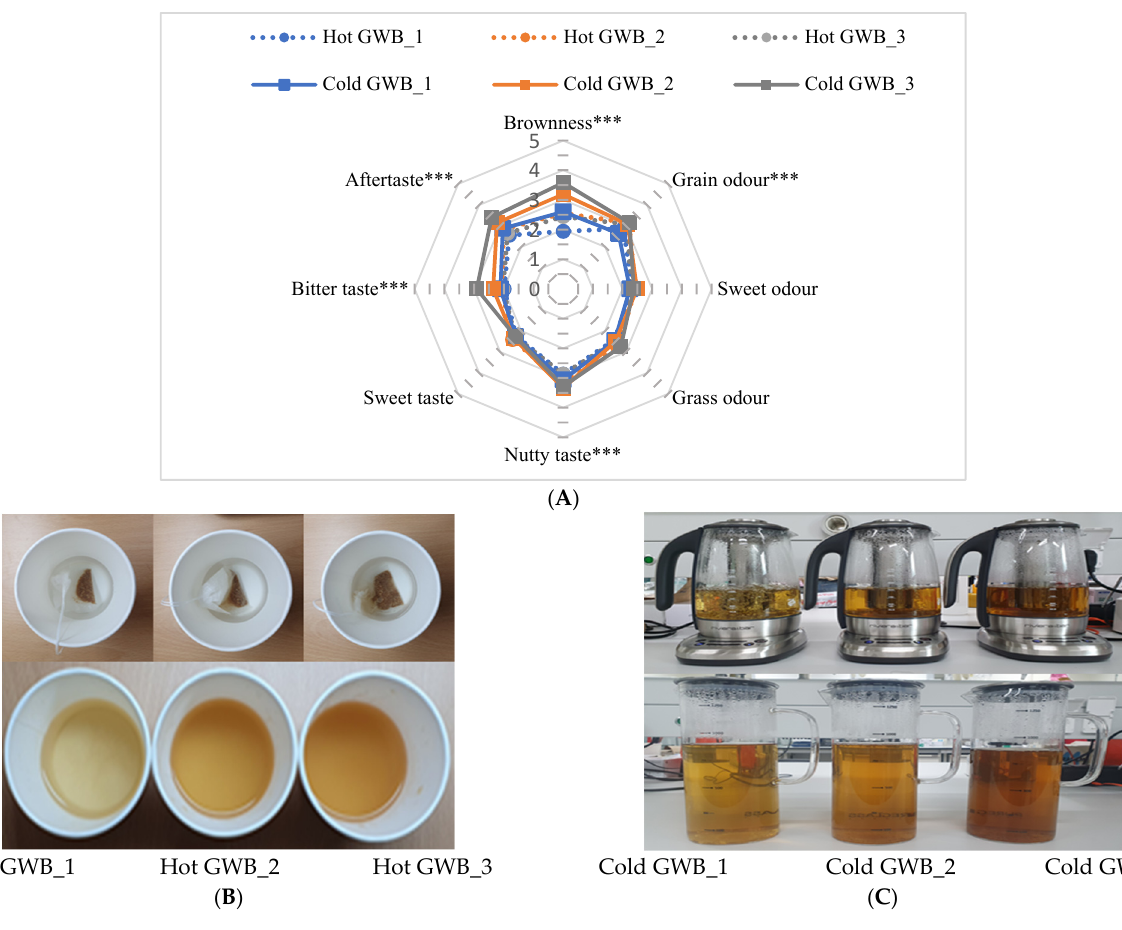
Figure 2. Spider chart for the intensities of sensory characteristics of germinated wheat beverage (GWB) prepared as ( A ) hot tea and cold beverage. Pictures of GWB prepared as ( B ) hot tea and ( C ) cold beverage. Hot GWB_1, Hot GWB_2, and Hot GWB_3 represent GWB prepared as hot tea at 0.8, 2, and 4 g/100 mL, respectively. Cold GWB_1, Cold GWB_2, and Cold GWB_3 represent GWB prepared as a cold beverage at 25, 50, and 75 g/1000 mL, respectively. *** indicates a significant difference at p < 0.001.